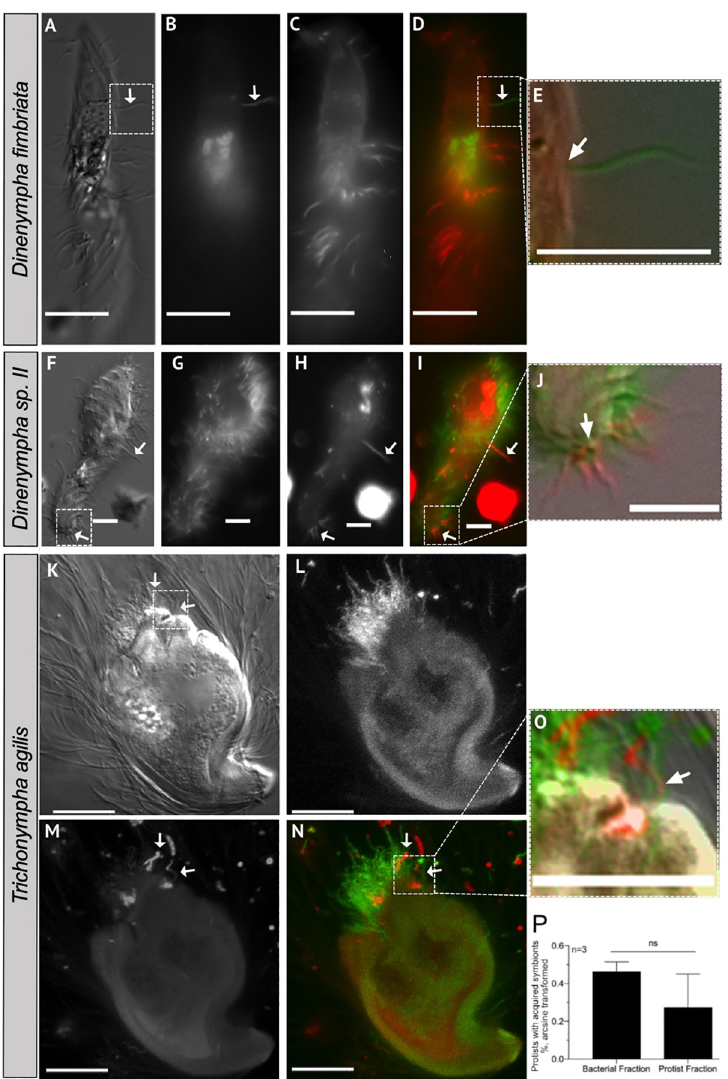
Fig 3. Horizontal acquisition of ectosymbionts by different protist species. DIC and fluorescence micrographs of hindgut protist and their ectosymbionts stained with either TRSE (shown red) or SE-488 (shown green) at Time = 12 hours of fluorescent acquisition assay. Overtime several different protist species including (A-E) D . fimbriata , (F—J) D . species II, and (K–O) T . agilis acquired new ectosymbionts. Micrographs are arranged from left to right as DIC, SE488, TRSE, and merged (SE488 and TRSE) for each protist. Fluorescence micrographs L–M are maximum intensity Z- projections. Micrographs E, J, and O represent areas which are zoomed in to demonstrate that the ectosymbionts are visibly attached to the host cell’s plasma membrane. Arrows point to horizontally acquired ectosymbionts and scale bars represent 10 μ m. (P) The average percent (arcsine transformed) of protists that acquired new bacteria from either the protist or bacterial cell fractions of termite hindguts at Time = 15 hours of the assays. Error bars represent the standard error of the mean and n = 3 independent experiments. Cycloheximide has been used to target protein synthesis across different protist taxa [41,42]. Over time, samples which were treated with tetracycline had significantly fewer protists that acquired new ectosymbionts compared to the no-treatment control (Two-tailed T-test, Time = 20 hours, t = 5.278, df = 3, p = 0.0133) (Fig 4A). Other control experiments showed that bacteria were not killed by tetracycline over the 20 hour time course of the experiment (not shown) These data indicated that inhibiting protein synthesis in the bacteria may have